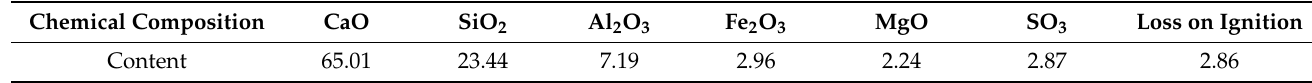
Table 1. Chemical composition of cement P. O. 42.5 R (%).